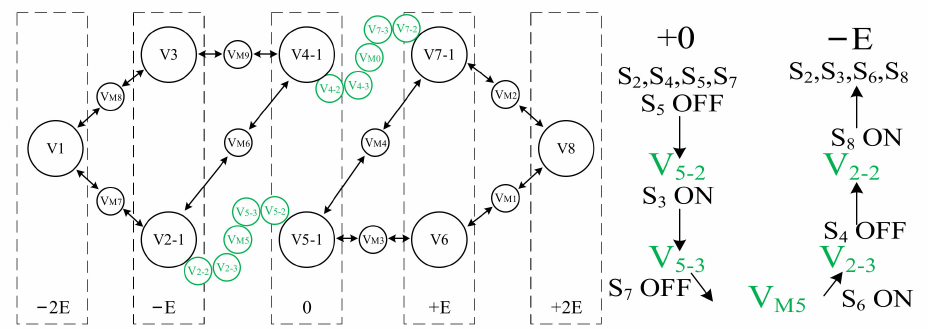
Figure 10. Complete state machine for the ANPC-5L process.